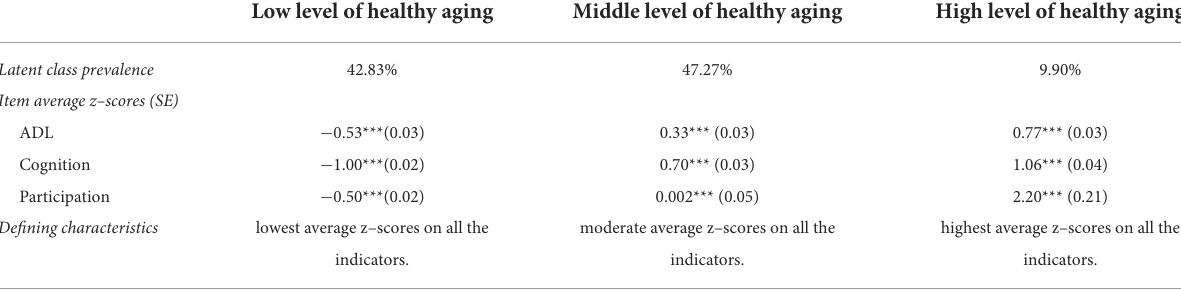
TABLE 3 Three-class model of healthy aging levels among Chinese older adults with disabilities ( N =